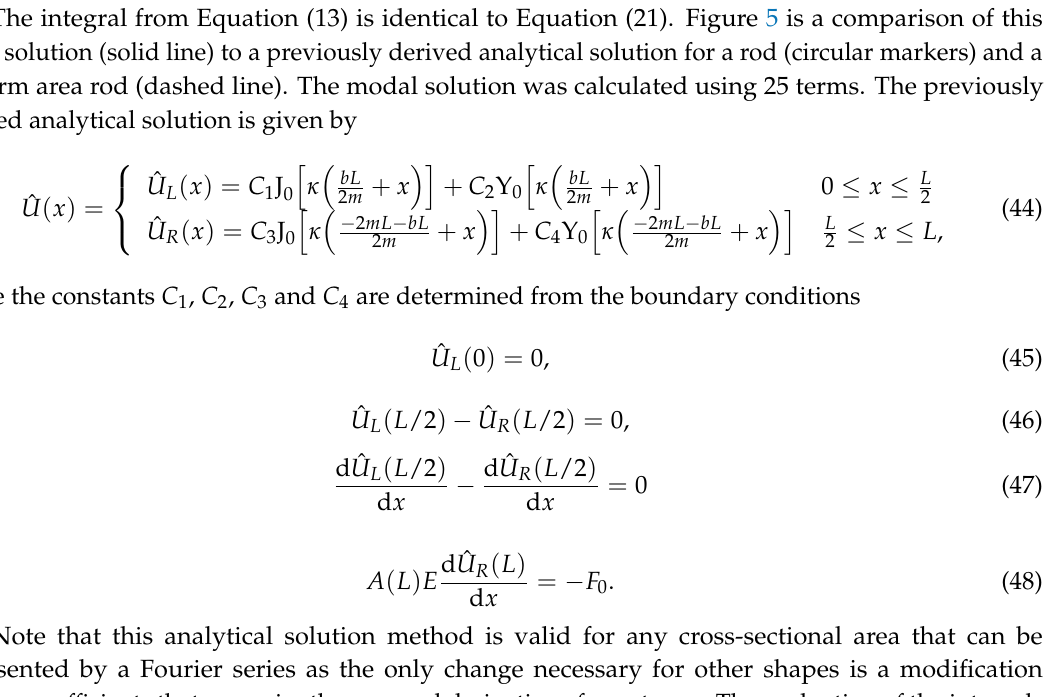
Figure 4. Fixed-free rod with a triangular change of area.